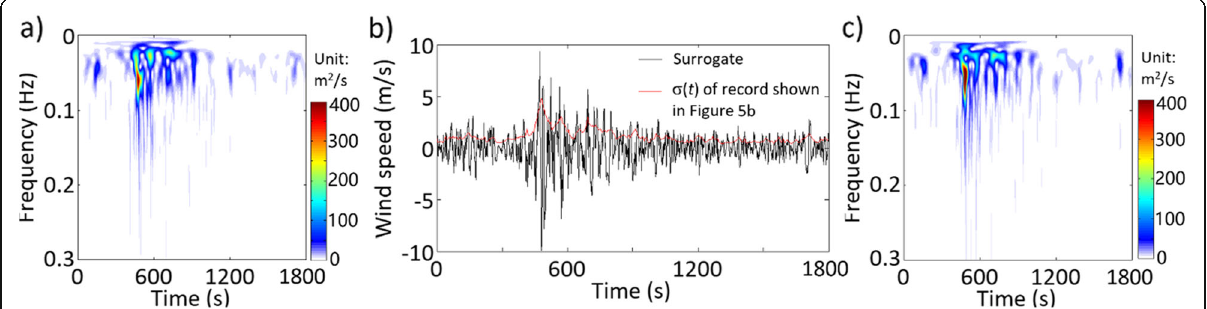
Fig. 6 Results by using ST for the wind record shown in Fig. 5b: a TFPSD of the given record, b a generated surrogate and σ ( t ) of the given record, and c TFPSD of the generated surrogate shown in Fig.